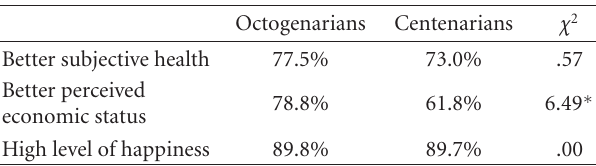
Table 3: Proportion of alternative successful aging